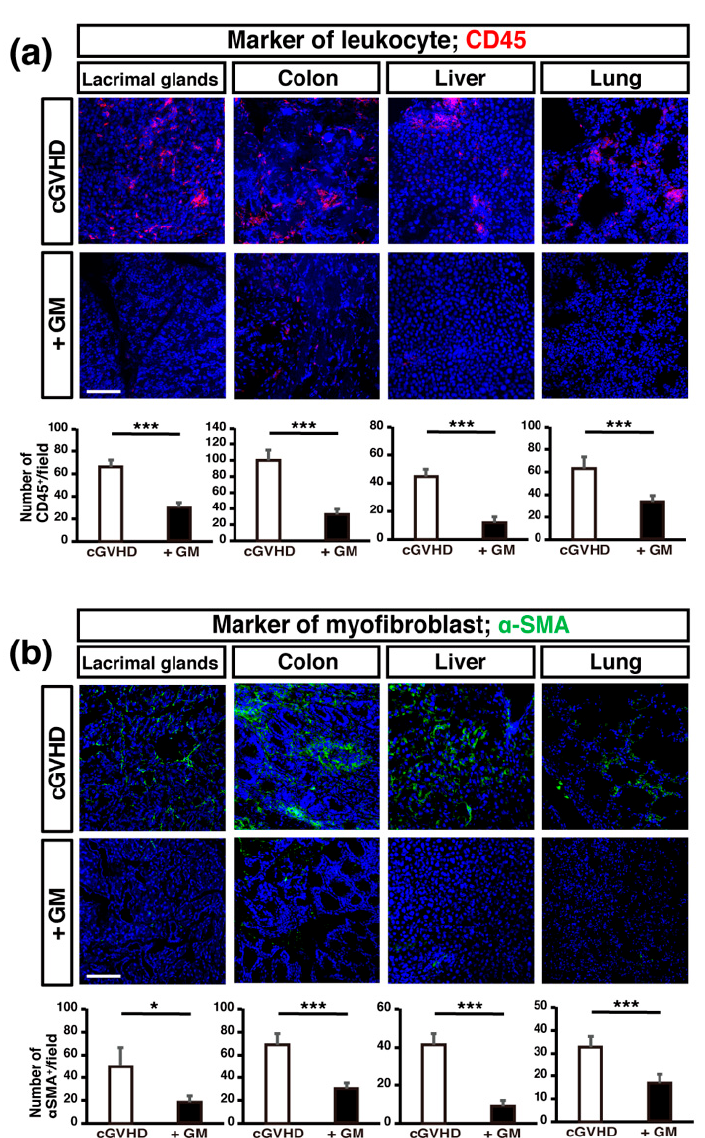
Figure 3. The expression of leukocyte and myofibroblast markers are suppressed in cGVHD-targeted organs in gentamicin-treated cGVHD mice: ( a , b ) sections of cGVHD-targeted organs (lacrimal glands, colons, livers, and lungs) from non-treated cGVHD mice ( n = 5, five fields per sample) and gentamicin- treated cGVHD mice (+GM) ( n = 5, five fields per sample) were stained for cluster of differentiation (CD)45 (leukocyte marker) and α -smooth muscle actin ( α -SMA) (myofibroblast marker) (green). Data are presented as mean ± SEM. * p <0.05, *** p <0.001, unpaired Student’s t -test. Scale bar, 100 µ m. Th17 cells, which produce interleukin (IL)-17A, are associated with cGVHD, since the blockade of programmed death 1, which suppresses IL-17A-producing cells, attenuates the manifestations of cGVHD in the skin, liver, and salivary glands [33]. Increased IL-6 production during an autoimmune reaction leads to the induction of Th17 cells and a reduction in the Tregs population [34]. To examine the balance between Th17 cells and Tregs in GM-treated cGVHD mice, we analyzed the expression of Th17 and Treg markers. The number of IL-17 + CD4 + cells (Th17 cells) in LGs was significantly higher in the non- treated group than in the GM-treated group (Figure 4a), and the mRNA expression of Il17a in the LGs was significantly suppressed in GM-treated mice compared to that in non-treated control mice (Figure 4b), indicating that GM administration may suppress Th17 T cell differentiation in the LGs of cGVHD mice. The number of CD4 + CD25 + Foxp3